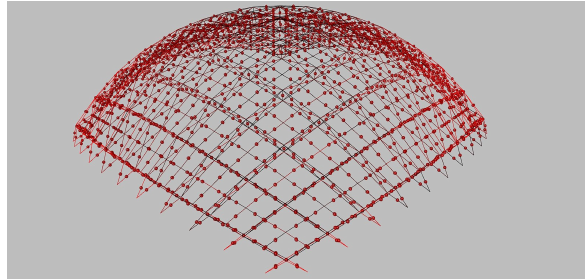
Figure 10: 3D model of the structure of the Sports Palace of Mexico City using parametric